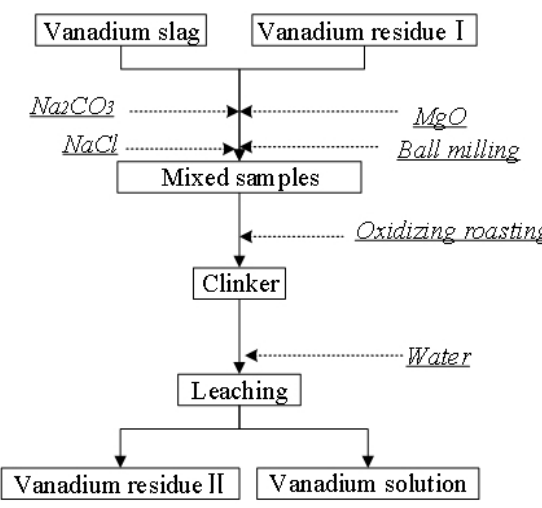
Figure 2. Flow chat of experiment.